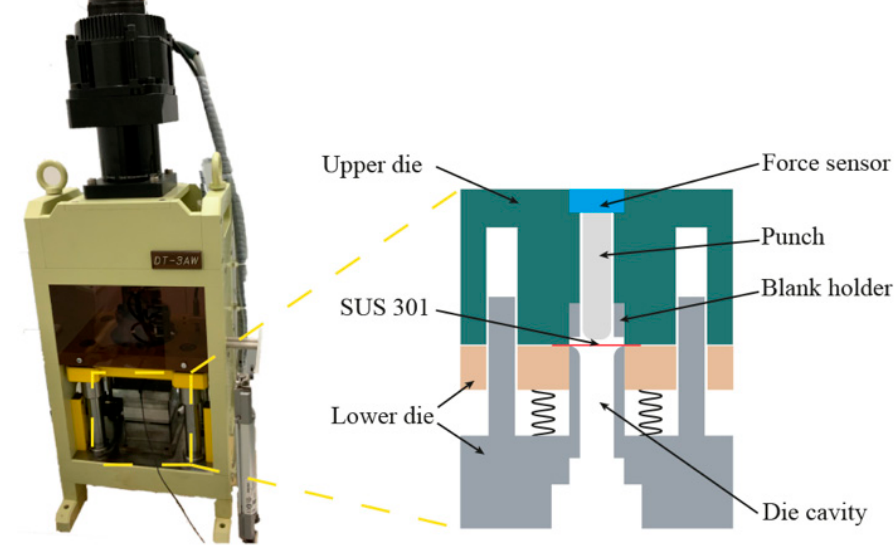
Figure 2. MDD apparatus and its schematic illustration.